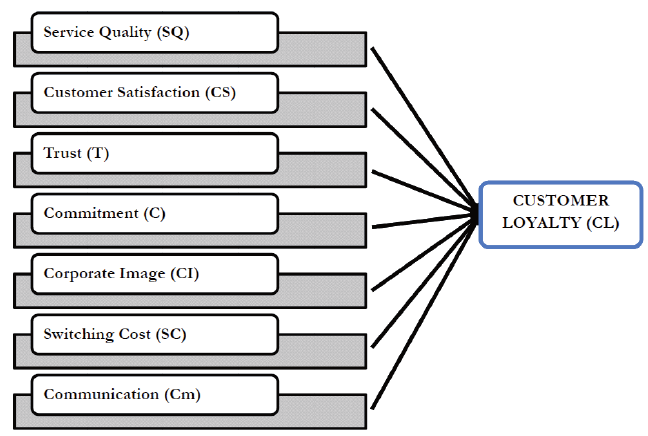
Fig. 2 - Customer Loyalty Formation. Source: own